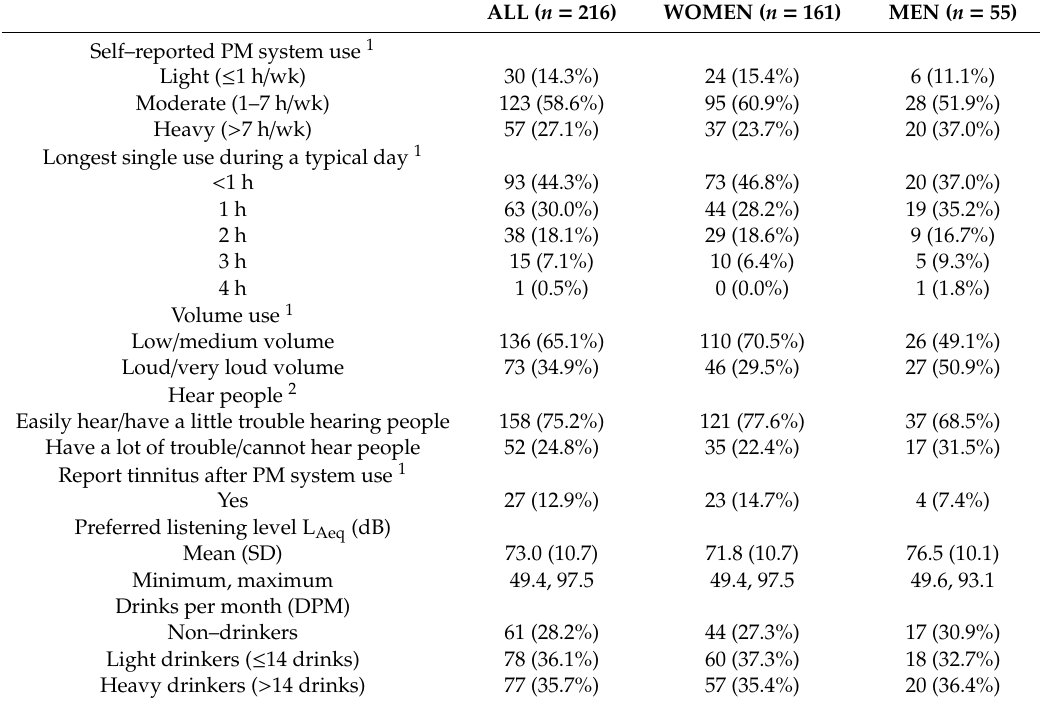
Table 2. The number, and percentages of participants who reported listening to a PM system at Low / medium volume and Loud / very loud volume and who reported number of drinks per month are shown. The means, standard deviations, minimums, and maximums for preferred listening level are also presented. These data are further separated for women and